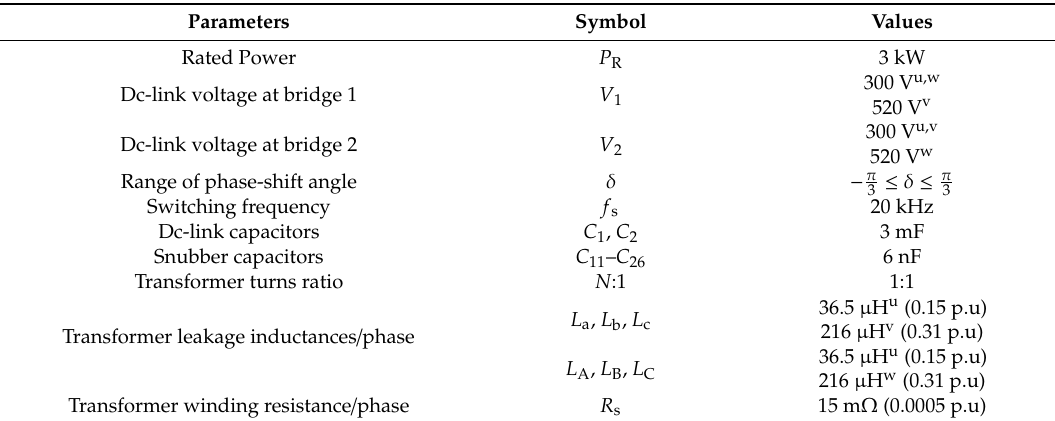
Figure 5. Simulation model of the three-phase bidirectional isolated DC-DC converter (3P-BIDC) with the Yy transformer connection. Table 1. 3P-BIDC Circuit Parameters.